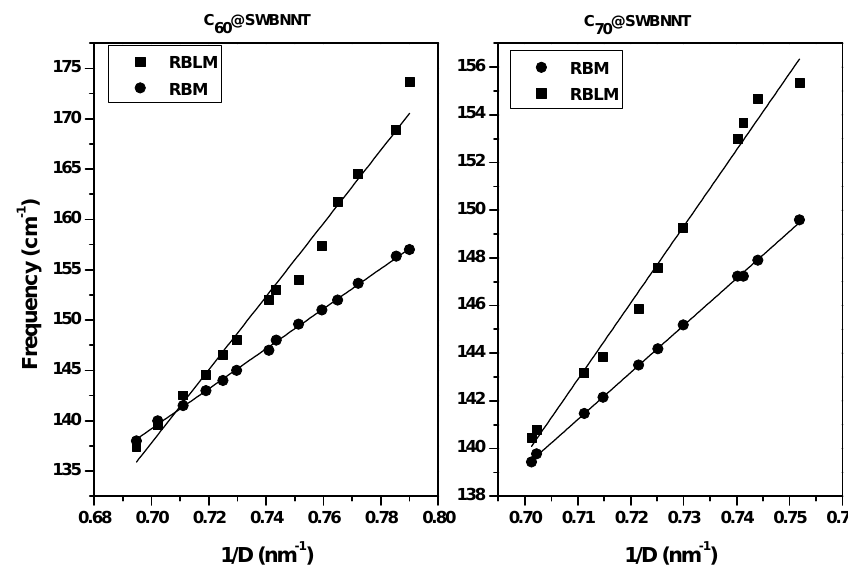
Figure 4. Calculated RBLM frequencies (squares) in isolated infinite nanopeapods and RBM (circles) frequencies in infinite isolated SWBNNTs. Only tubes with a diameter below 1.42 and 1.45 nm are considered for C 60 @SWBNNT and C 70 @SWBNNT,